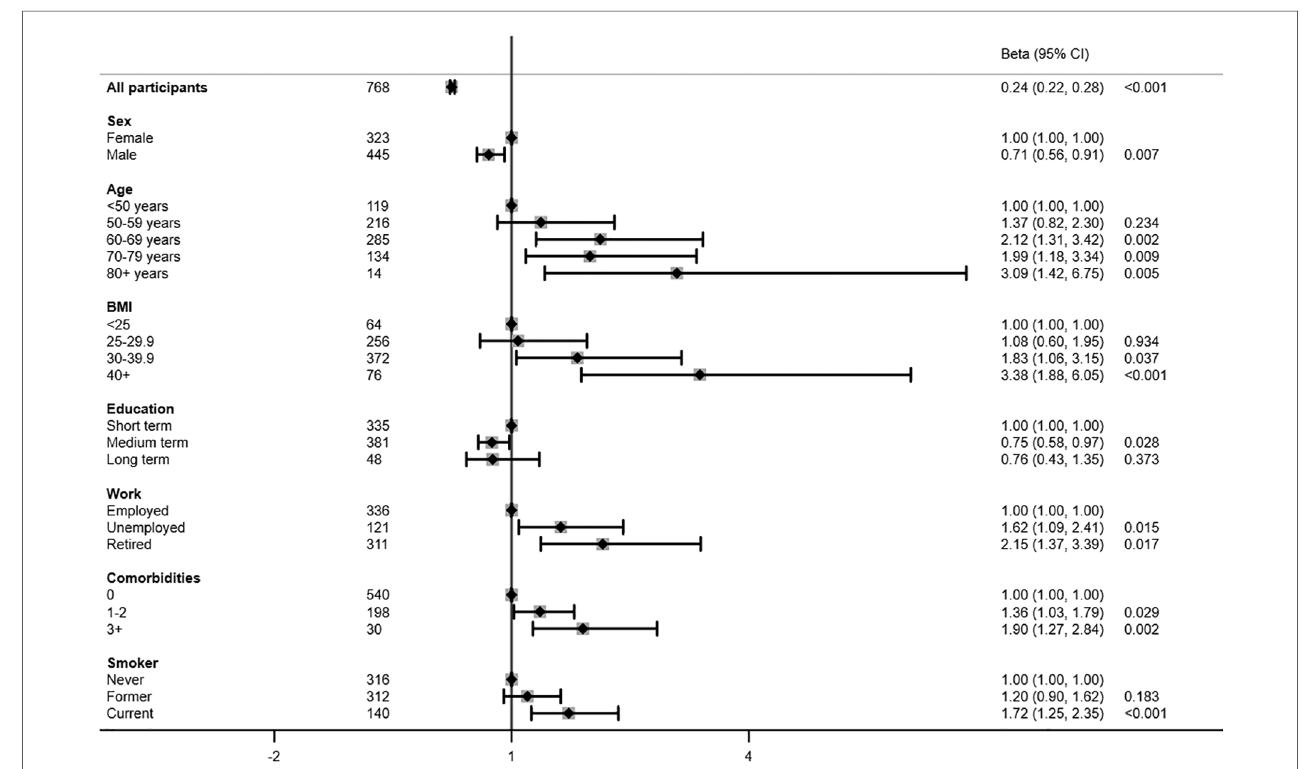
FIGURE 2 Risk factors associated with a high-risk physical activity pro fi le presented in prevalence rate ratios adjusted for age and sex.